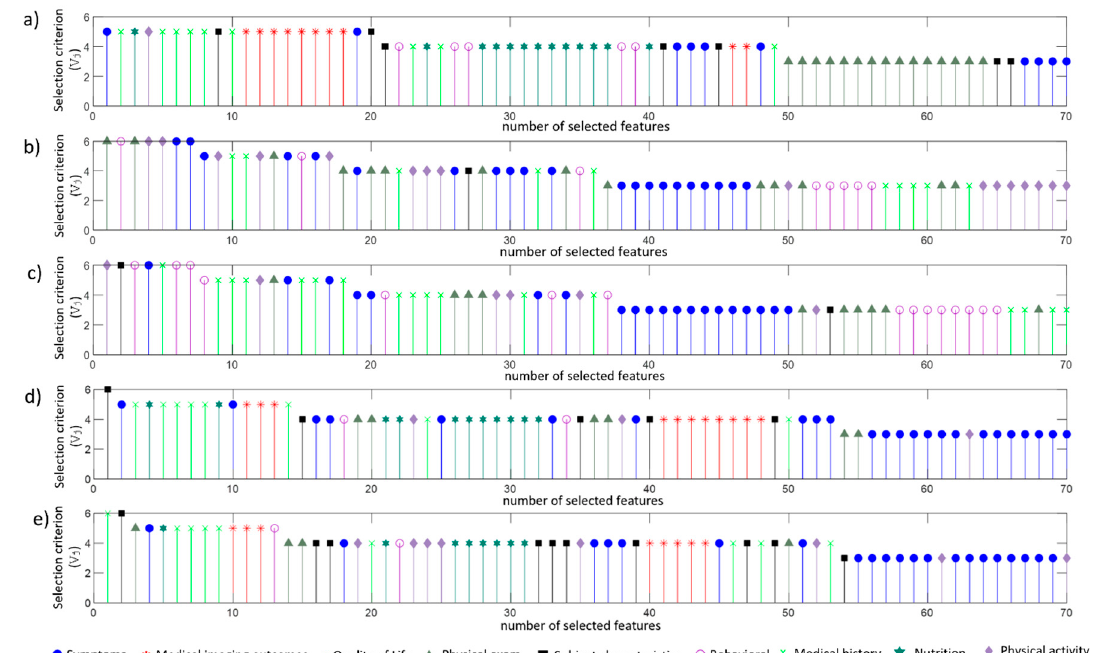
Figure 12. Features selected in datasets A to E in ( a – e ), respectively. Axis y (selection criterion) denotes how many times a feature has been selected (6 declares that a specific feature has been selected by all six FS techniques and so on). Features have been ranked based on the selection criterion V j and are visualised with different colors each one representing a specific feature category. Table 10. Testing performance (%) of the competing FS techniques with respect to the number of selected features for dataset